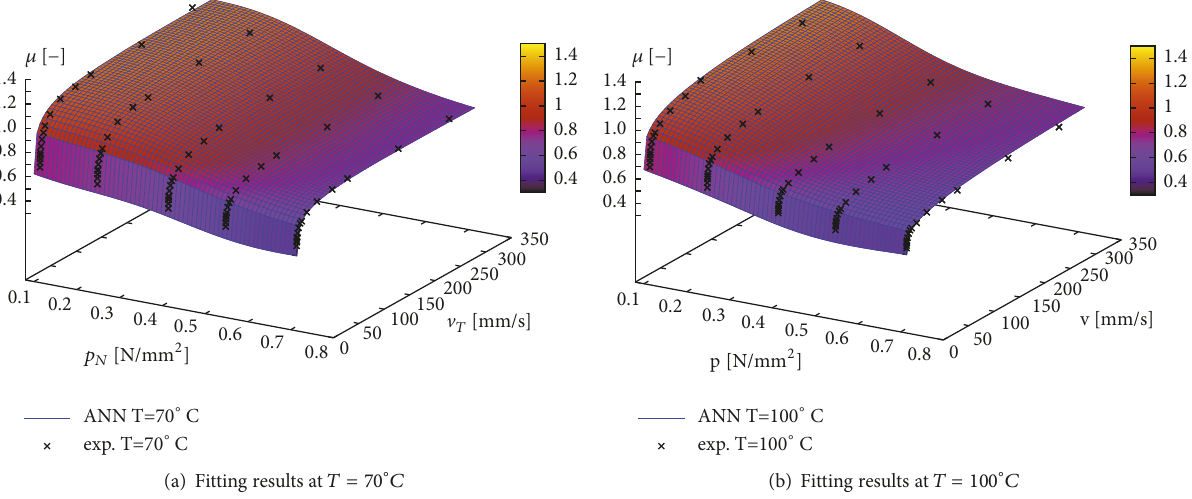
Figure 3: Friction coefficient response surfaces provided by ANN for experimental results at 𝑇 = 70 ∘ 𝐶 and 𝑇 = 100 ∘ 𝐶